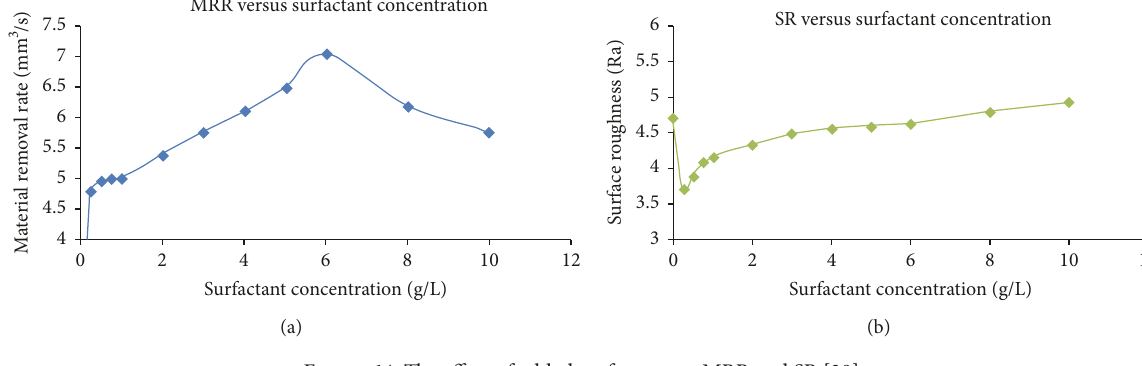
Figure 13: SEM micrograph of (a) EDMed (b) PMEDMed surfaces. Copyright @Elsevier, reproduced with permission from Elsevier [138]. MRR versus surfactant concentration